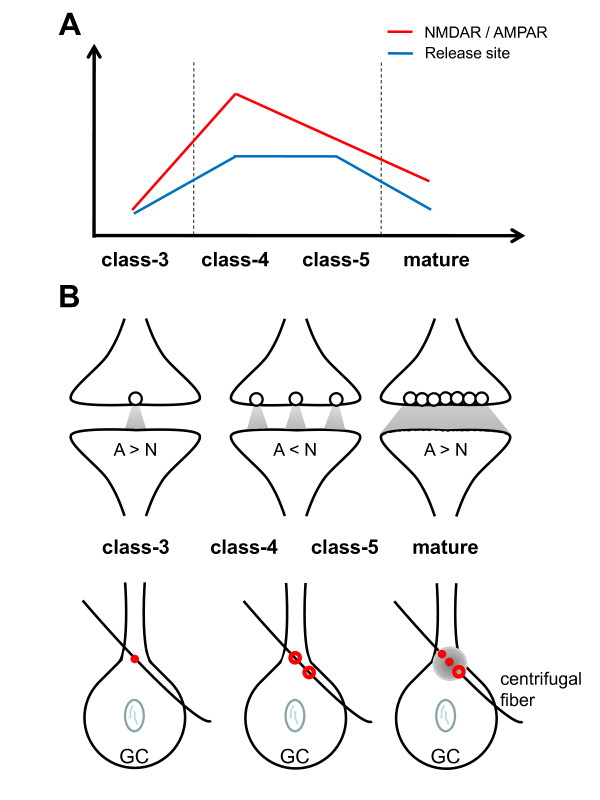
Schematic diagram of an axodendritic synapse for each class of GC. (A) Time-course analysis of two elements during the maturation of the first glutamatergic contact onto newborn GCs. The NMDAR/AMPAR ratios are shown in red. Functional release sites (blue) are indicated as either single or multiple. Both class 4 and class 5 neurons showed a high NMDAR/AMPAR ratio with multiple release sites. (B) Developmental changes in a single axodendritic synapse. Top: Transmitter vesicular events (circle) per action potential gradually changed from single to multiple events. Each event occurred independently, but seemed to become integrated together in mature GCs (gray). Bottom: Differences observed in the number of axodendritic synapses. During maturation, the number of synapses (red circles) impinging onto newborn GCs increased in parallel with the appearance of perforated synapse (red doughnut-like shape). At the later stages of maturation, perforated synapses then divided, with a spillover of transmitter occurring at adjacent synapses (gray).